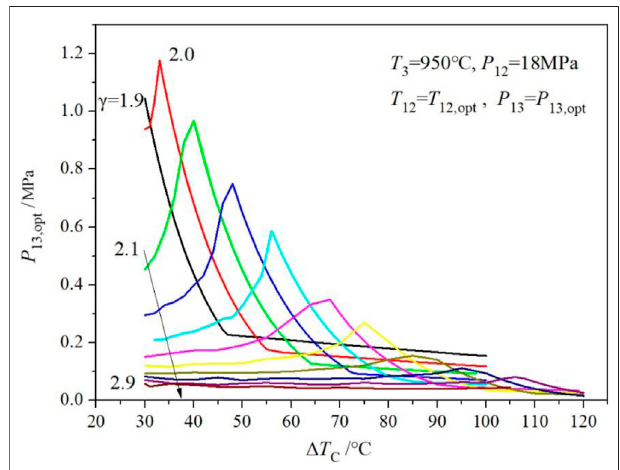
FIGURE 5 | Corresponding optimized value of steam turbine extraction pressure.